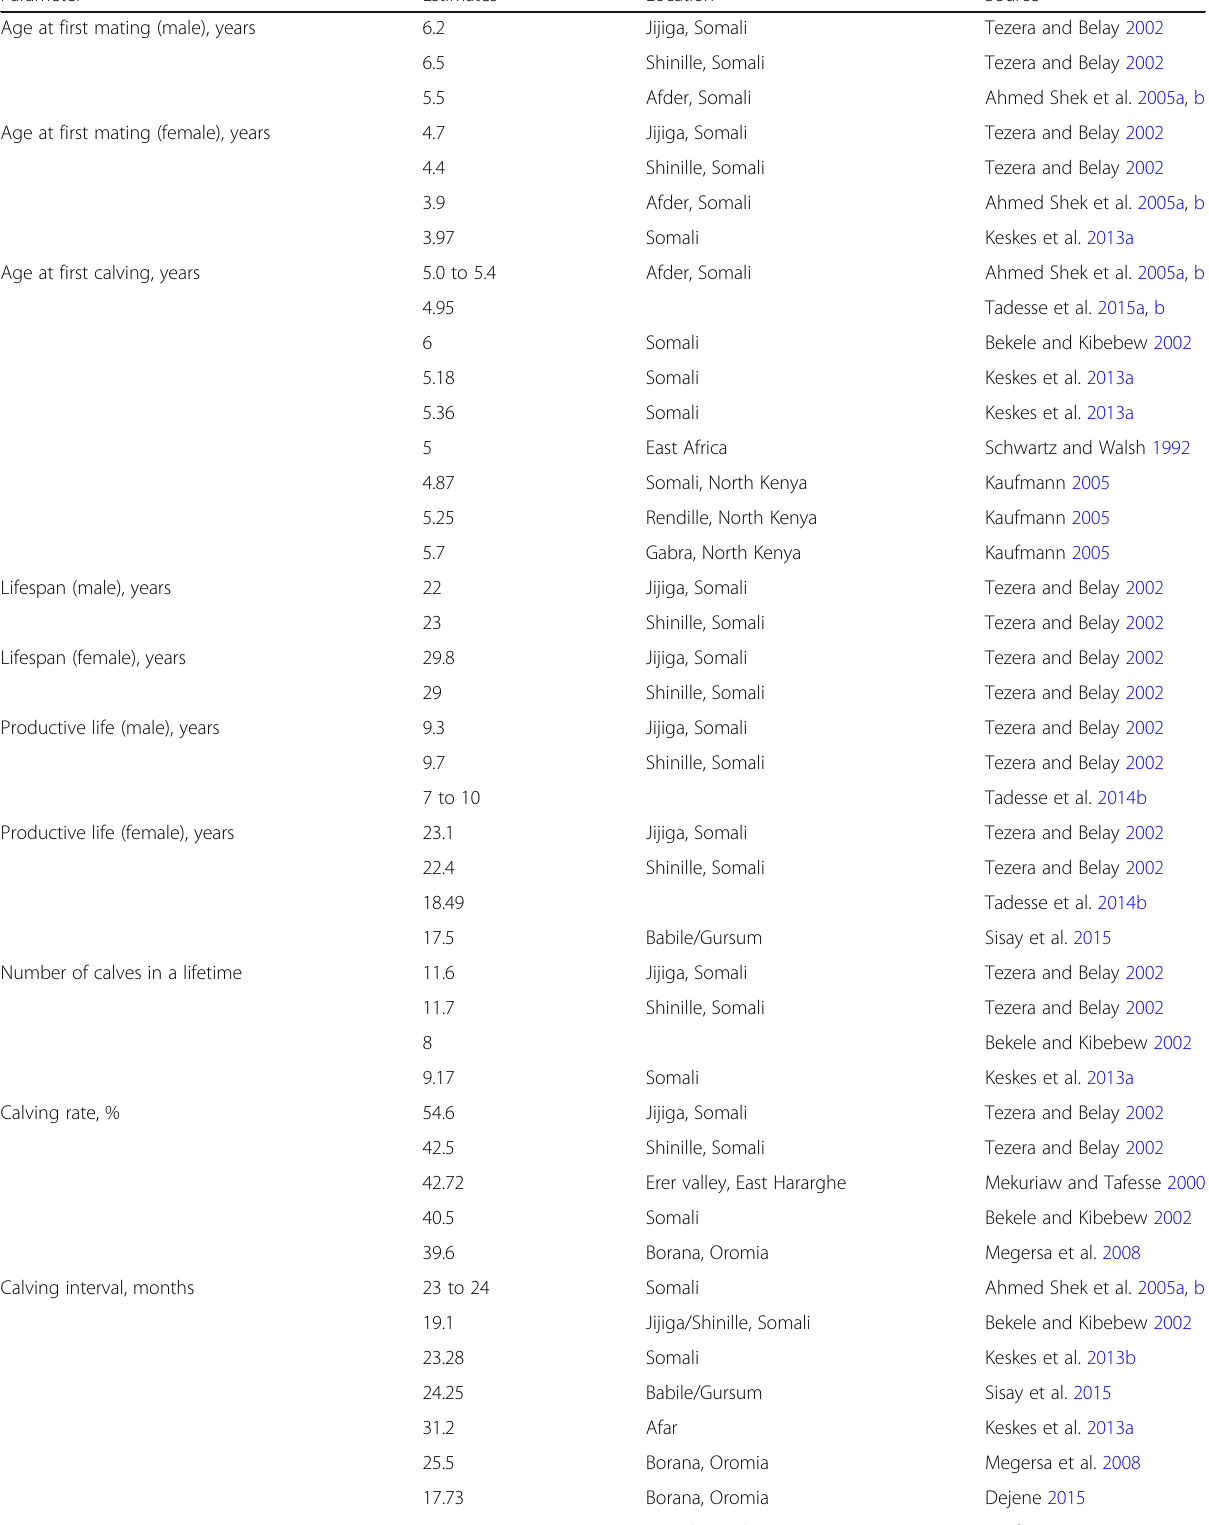
Table 4 Estimates of reproductive performance of camels in different areas of Ethiopia Parameter